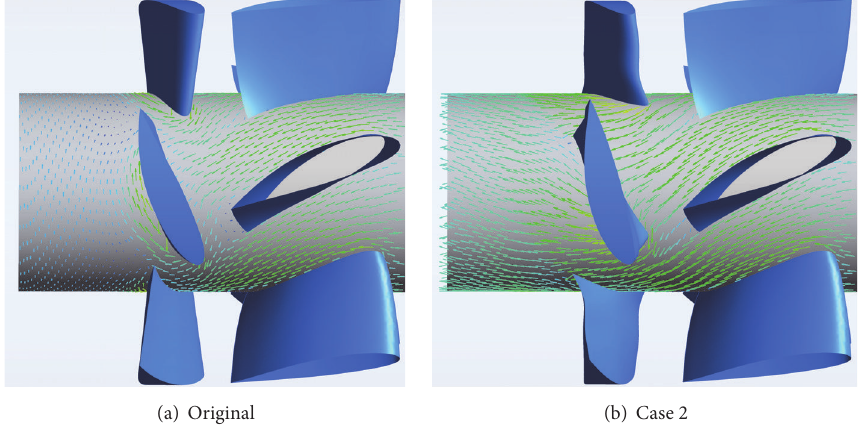
Figure 11: Absolute velocity vector ( 𝜑 = 0.125, 𝑛 = 2460 min −1 , Cal.).